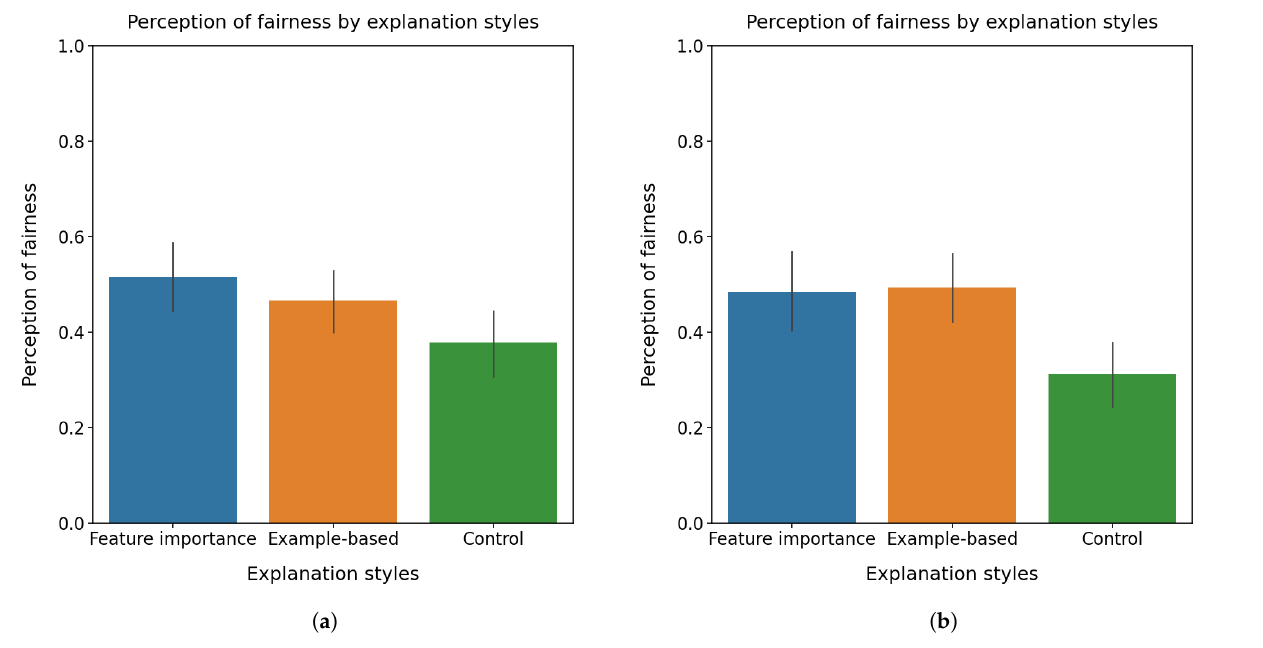
Figure 11. Perception of fairness over explanation types in two scenarios. ( a ) Health insurance decision-making. ( b ) Medical treatment